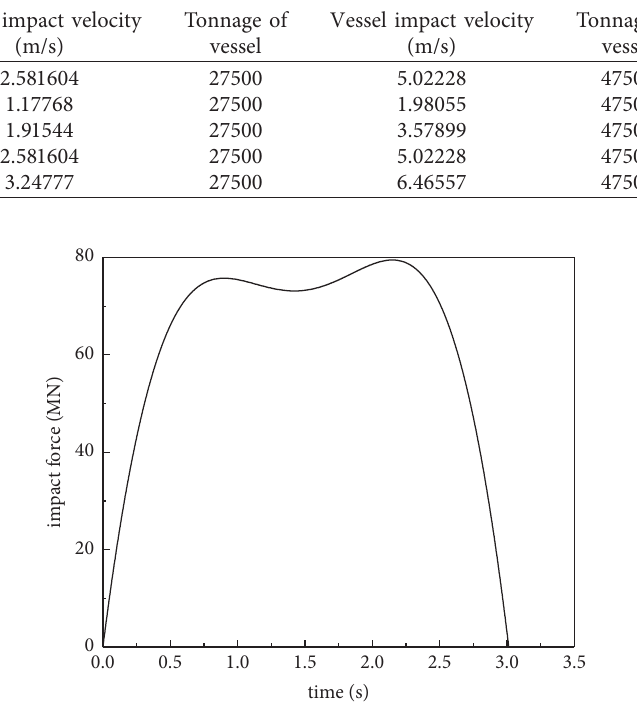
Figure 4: Time-history curve of vessel collision load at DWT � 27500, v �